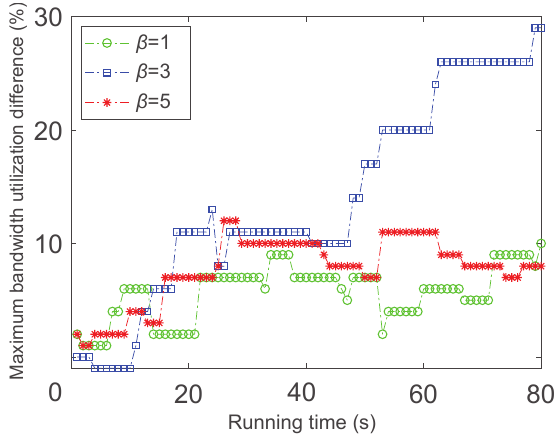
Fig. 11 Bandwidth difference for changing ˇˇˇ